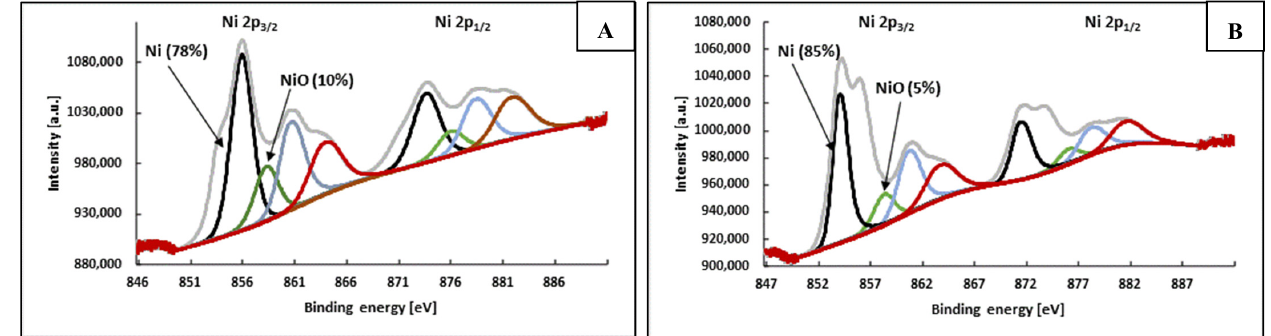
Figure 7. XPS of Ni@Ag NP coatings (after sintering at 100 °C for 30 min) without OA treatment ( A ) and after treatment with 1 wt% OA ( B ) (metallic Ni—black curves, NiO—green curves, Ni 2+ —red curves, satellites—blue curves.